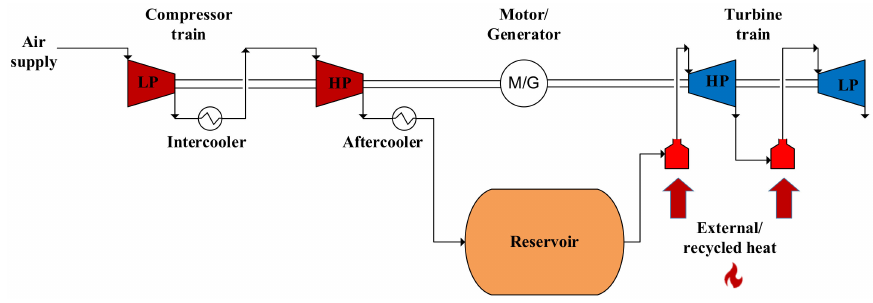
Figure 1. CAES system process flow diagram. Adapted from Huntorf layout